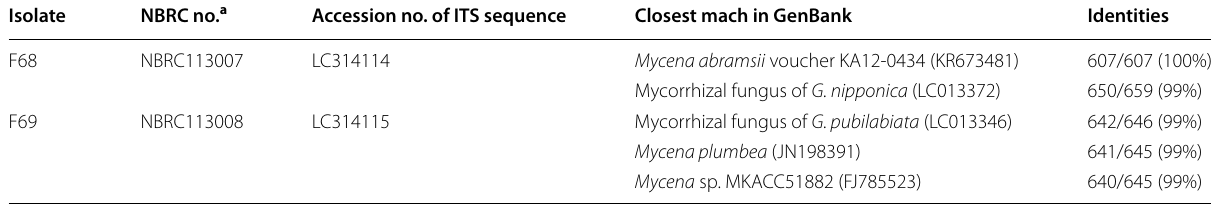
Table 2 The results of molecular identification of the fungal isolates from G. pubilabiata seedlings Isolate NBRC no.